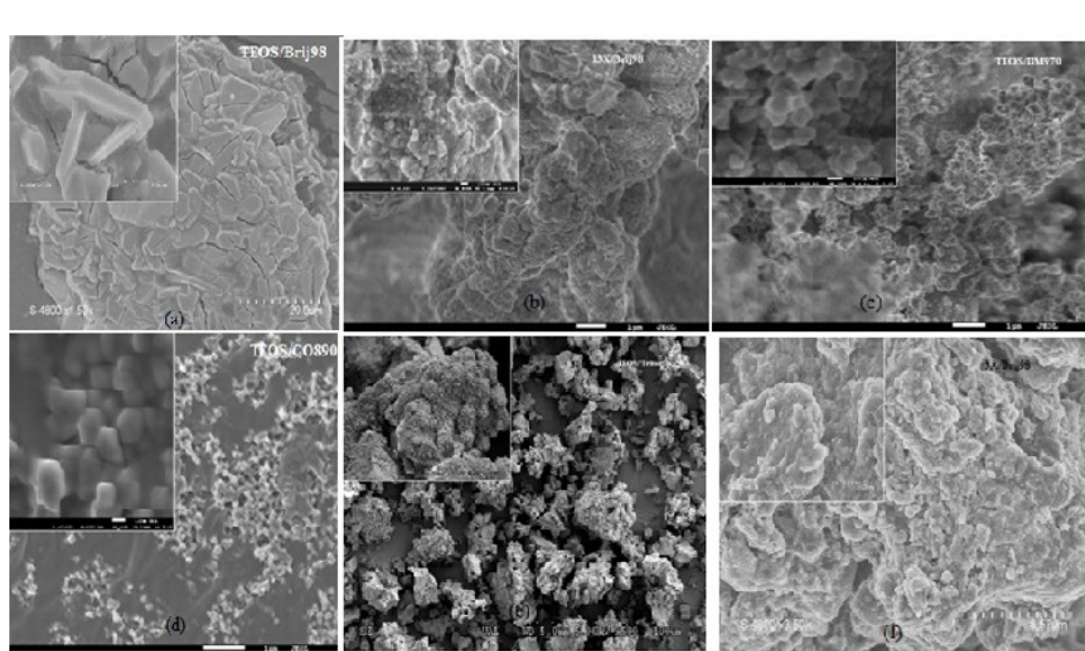
Figure 2. Scanning electron micrographs (SEM) of: TEOS/Brij98 and 13X/Brij98 (top); TEOS/DM-970 and TEOS/CO-890 (bottom).